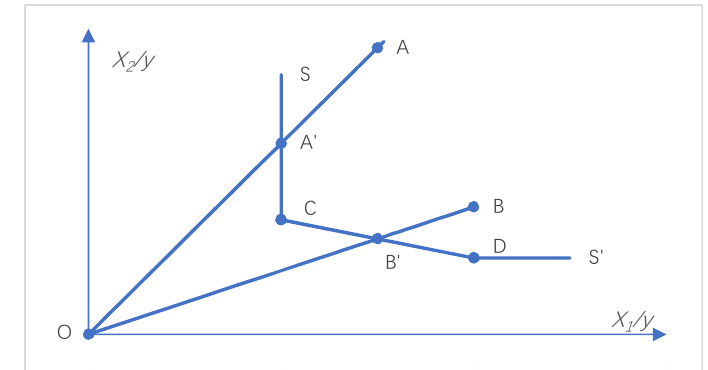
Figure 1. Efficiency measure and input slacks. Figure 1. E ffi ciency measure and input